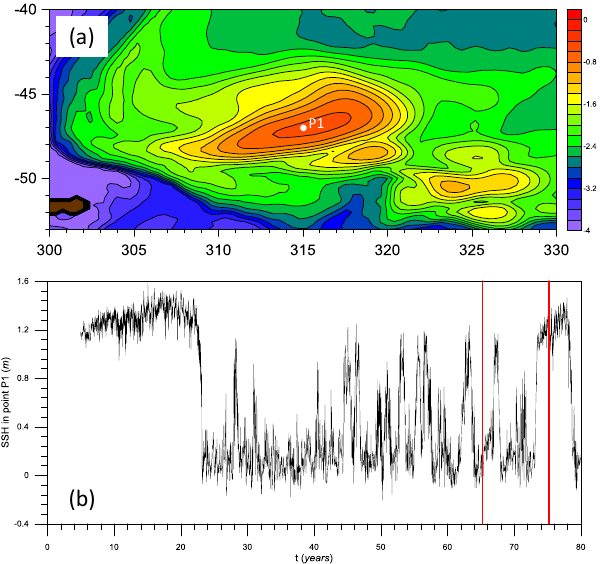
Fig. 7. (a) Logarithm of the rms of the low-frequency SSH signal in the Argentine Basin. (b) SSH at P1 (the analyses are carried out within the 10-year reference interval delimited by the red lines).